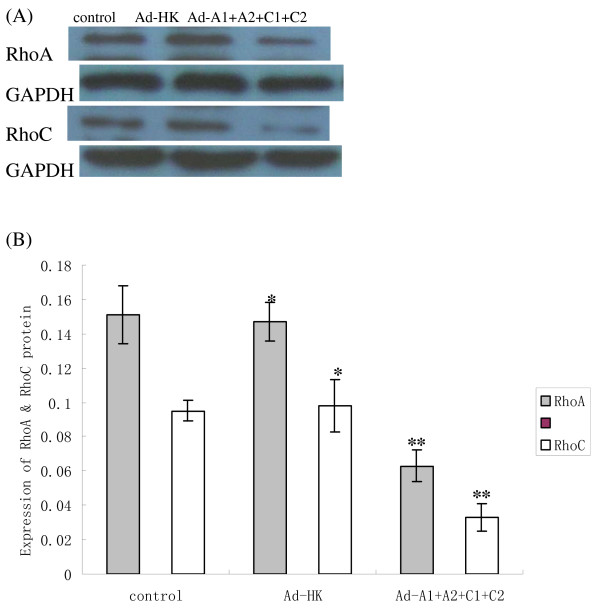
indicates protein levels in HCT116 cells. The RhoA and RhoC proteins from cells infected with Ad-A1+A2+C1+C2 were significantly weaker than those from control cells or from cells infected with Ad-HK. GAPDH is used as a loading control (A). The graph (B) compares scanning signal intensity of RhoA and RhoC expression by Imagel software. *P > 0.05, no significantly difference between the cells treated with Ad-HK and the control cells. **P < 0.05, compared with other groups.